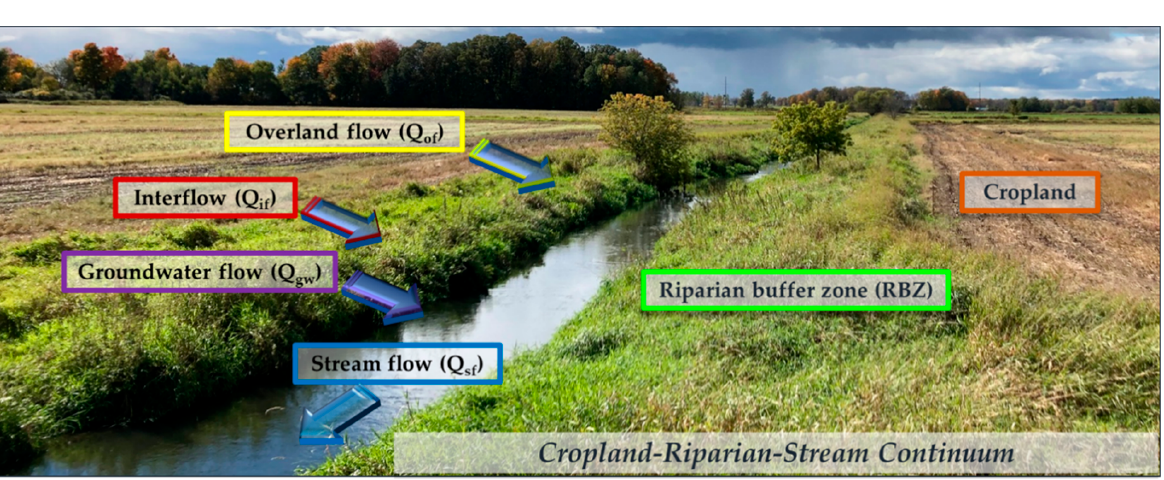
Figure 2. Hydrologic pathways contributing to streamflow along the cropland–riparian–stream continuum.